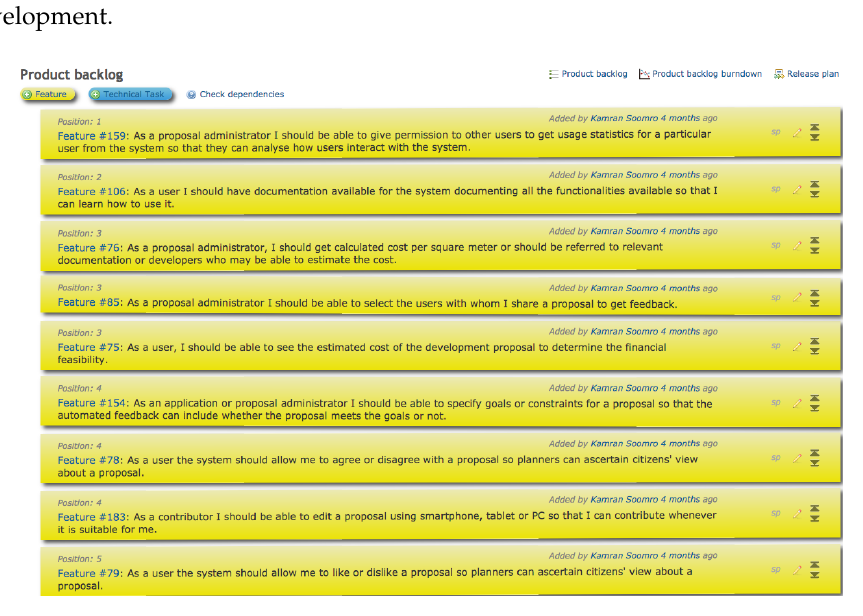
Figure 4. Product backlog—(total 117 features).